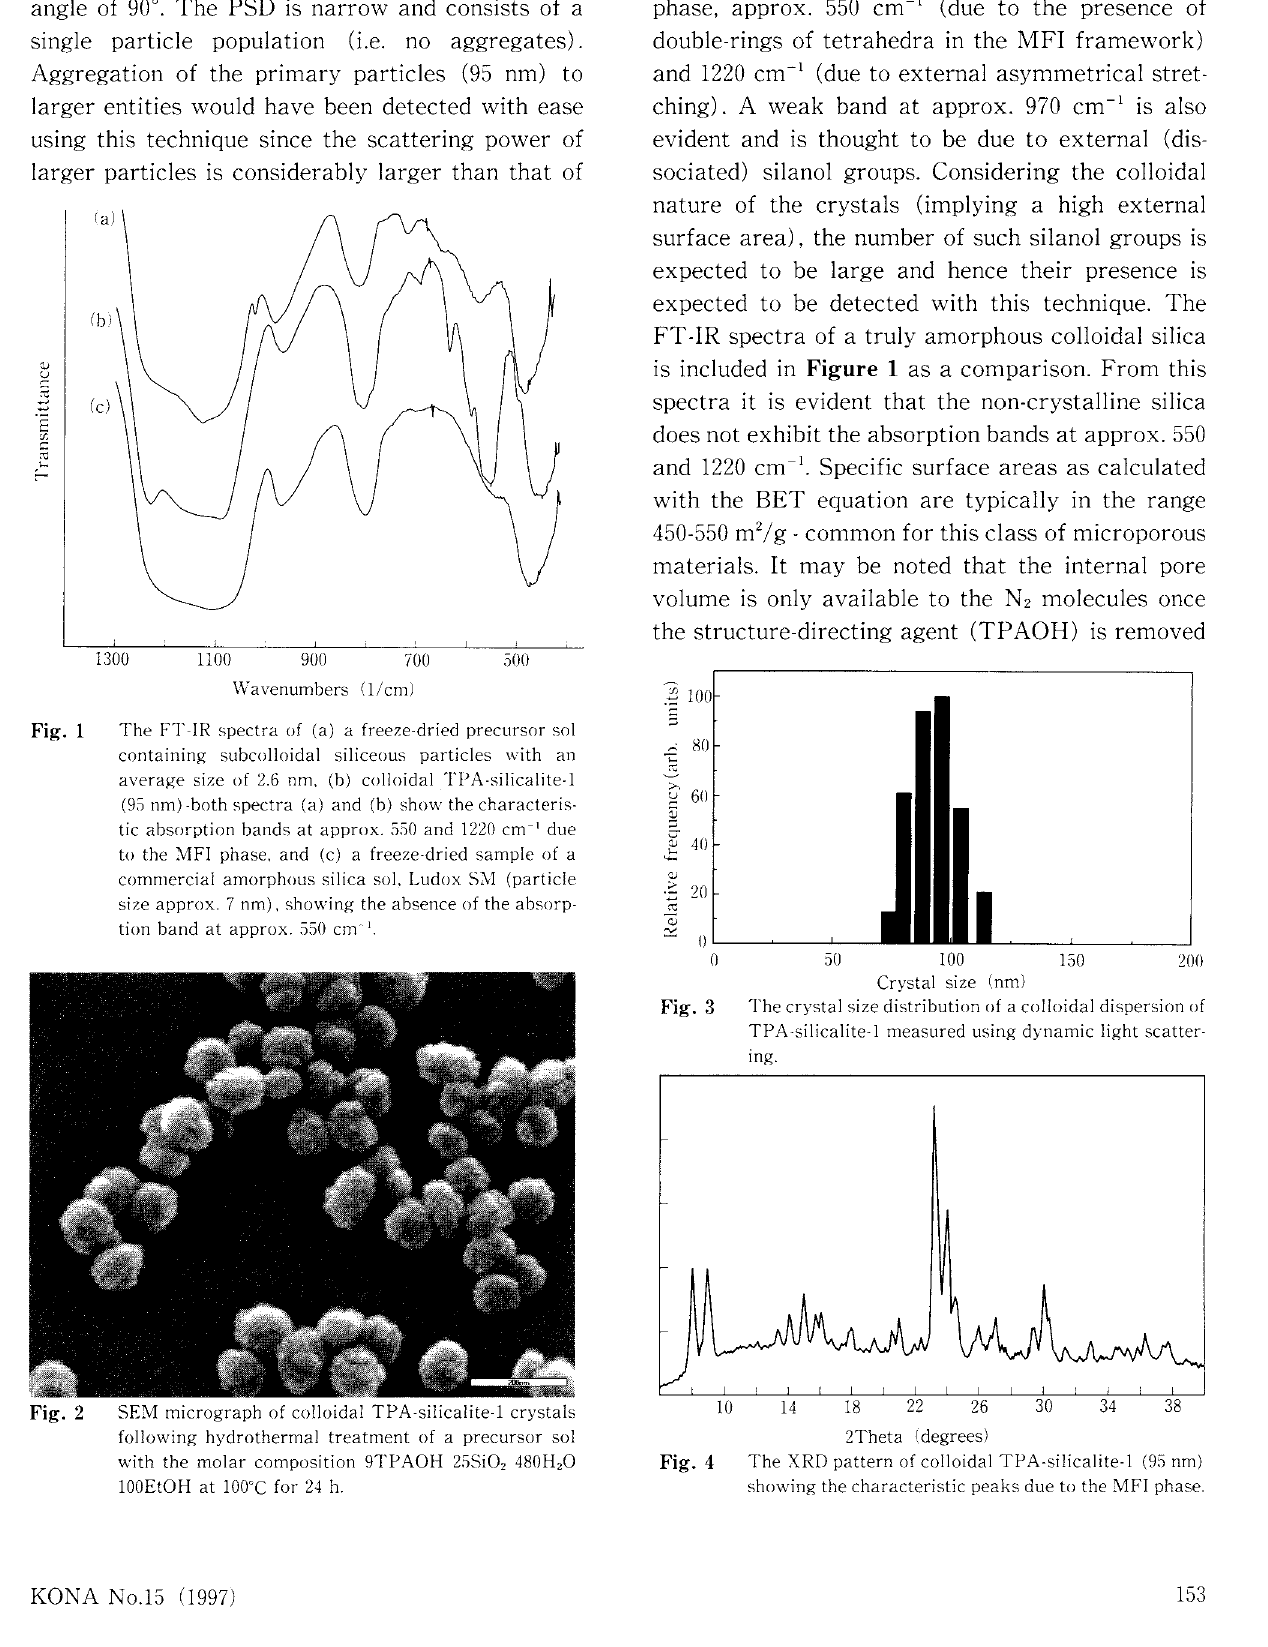
The XRD pattern of colloidal TPA-silicalite-1 (% nm) showing the characteristic peaks due to the MFI